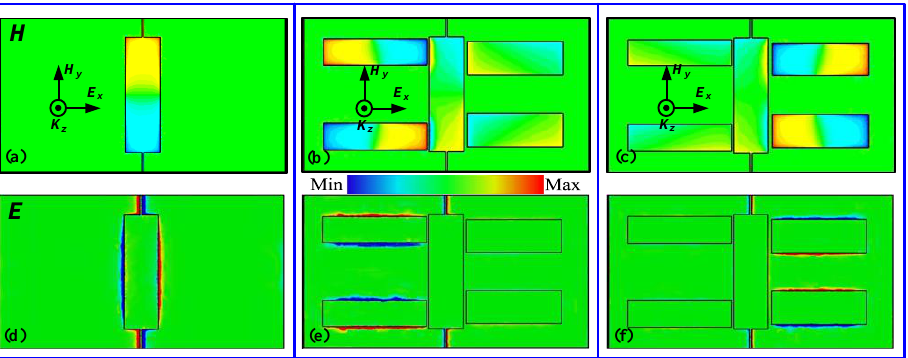
Figure 3. Magnetic and electric field distributions at different resonances: ( a , d ) at marked point “ A ” in Figure 2b, ( b , e ) at marked point “ B ” in Figure 2d, ( c , f ) at marked point “ C ” in Figure 2d.